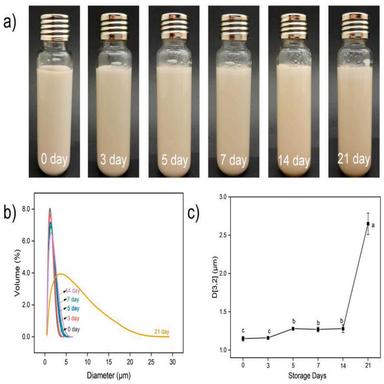
Characterization of MCNC-PE during storage. a) Visual images; b) Particle size distribution and c) D of MCNC-PE during storage (0 day, 3 day, 5 day, 7 day, 14 day and 21 day). Different letters indicate significant differences (p < 0.05). MCNC, magnetic cellulose nanocrystals; MCNC-PE, magnetic cellulose nanocrystals stabilized Pickering emulsion.